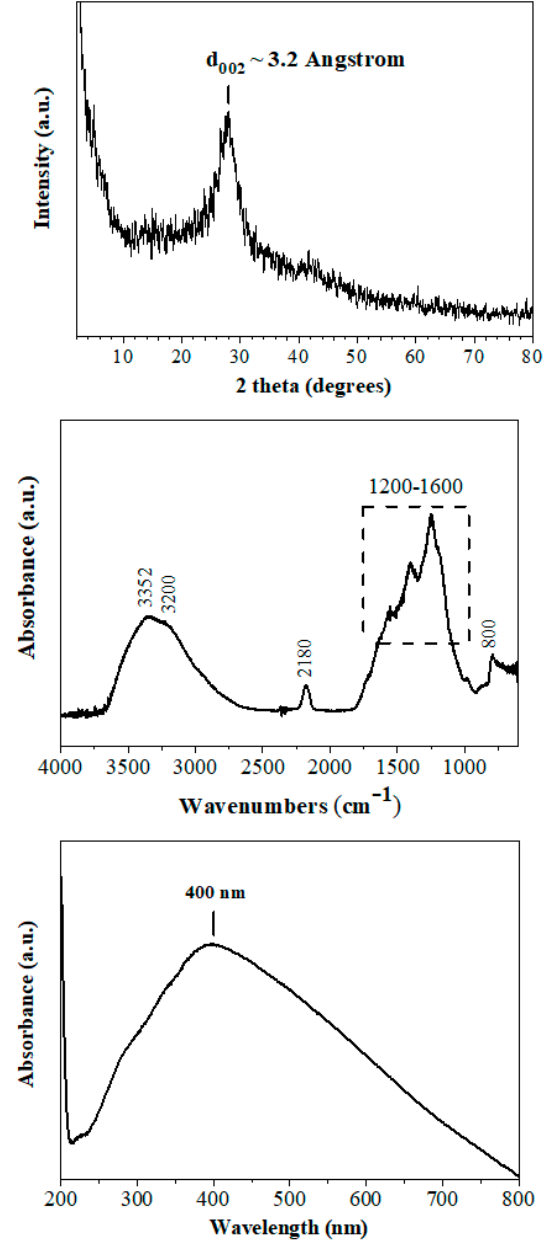
Figure 8. XRD pattern ( top ), Attenuated total reflectance-infrared spectroscopy (ATR-IR) spectrum ( middle ) and ultraviolet-visible (UV-Vis) spectrum ( bottom ); fine solid suspension in ethanol of the as-received graphitic carbon nitride.